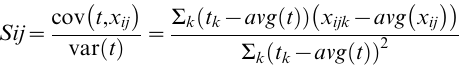
Table S1 Classification of 32 B-cell ligands into 4 groups